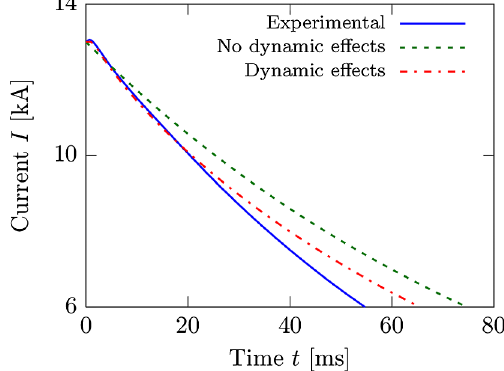
FIG. 3. Comparison between the experimental current decay (solid blue curve), a pure exponential (dashed green curve), and a QLASA simulation which considers dynamic effects on the inductance due to IFCCs (point-dashed red curve).